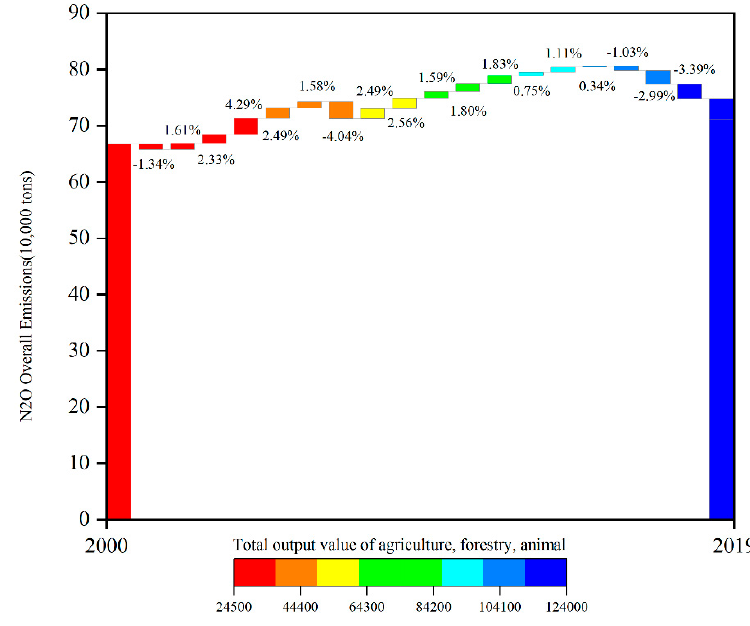
Figure 2. Agriculture-induced N 2 O Emissions from 2000–2019 in China.